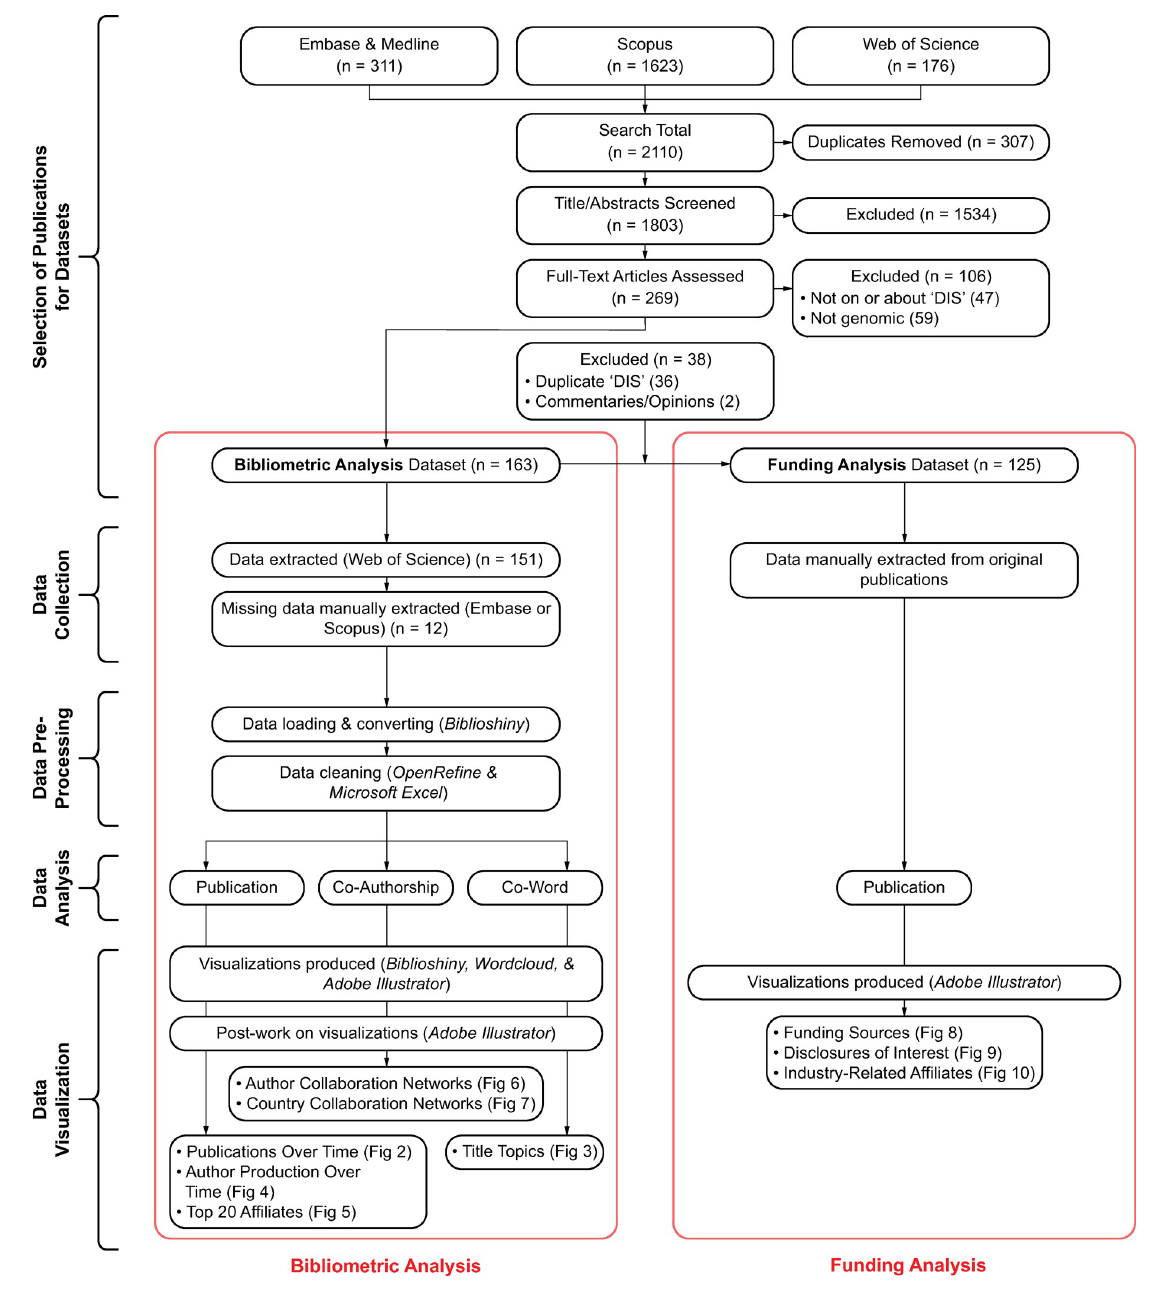
Fig 1. Flow diagram outlining the study